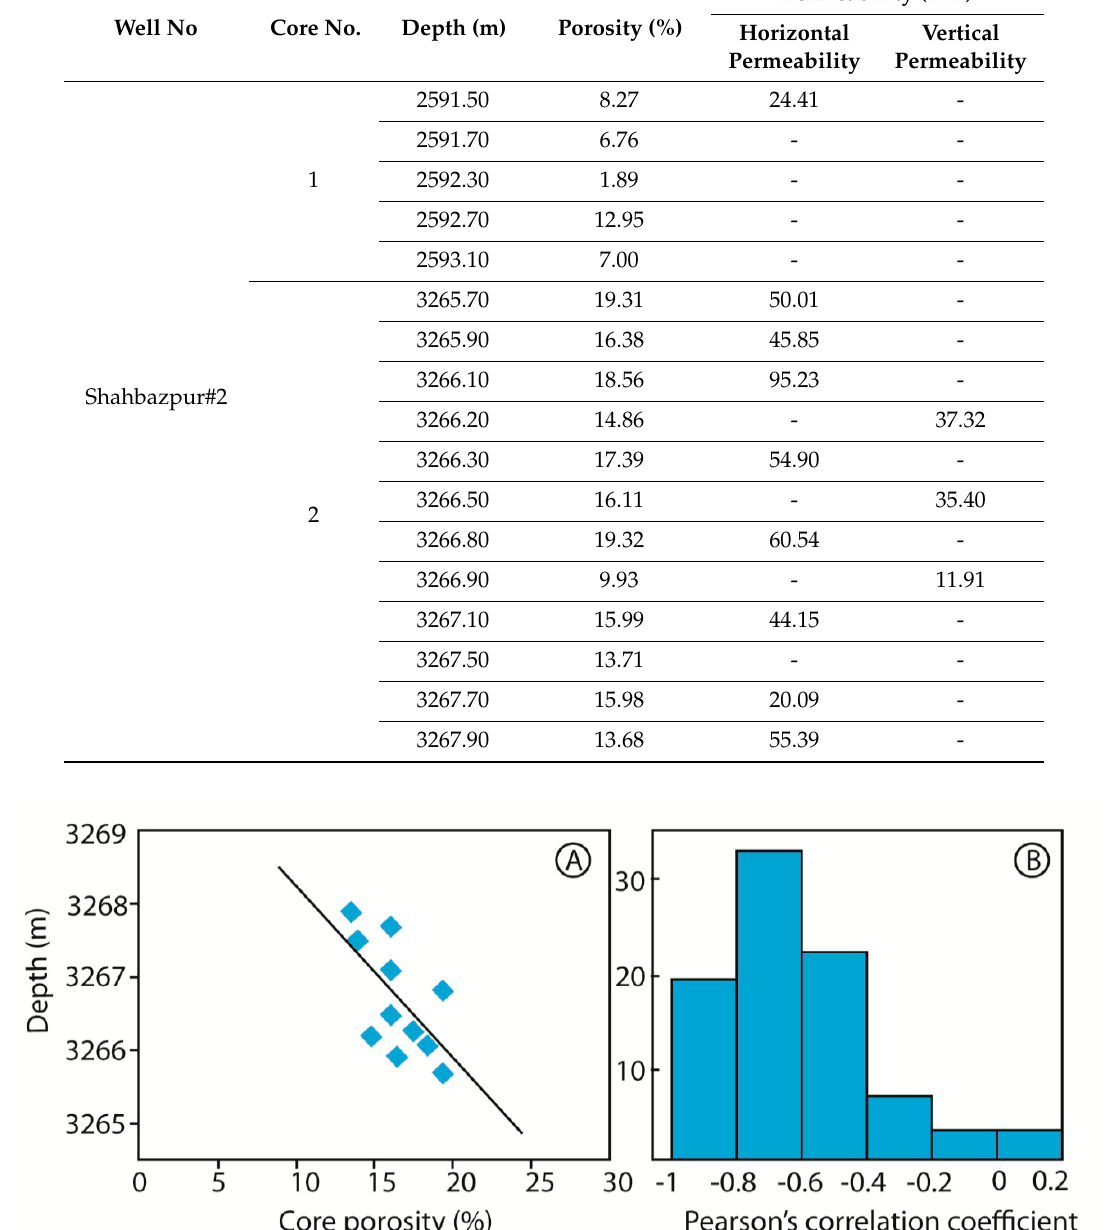
Figure 5. (A) Change of core permeability in relation to depth of Shahbazpur#2 sandstone samples; ( B ) histogram of bootstrapped Pearson’s correlation coefficient. Table 3. Core petrophysical parameters of Shahbazpur#2 well at different depths. Well No